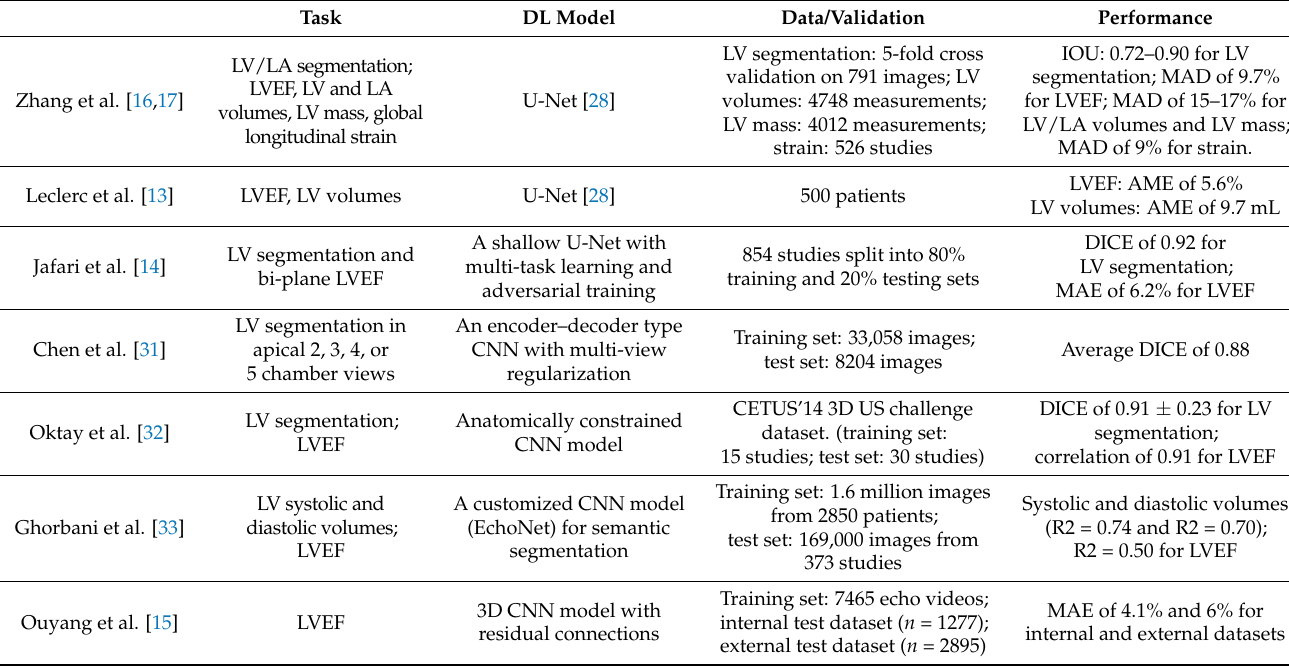
Table 3. Deep-learning-based AI studies for image segmentation and quantification. MAD: mean absolute difference. LVEF: left ventricle ejection